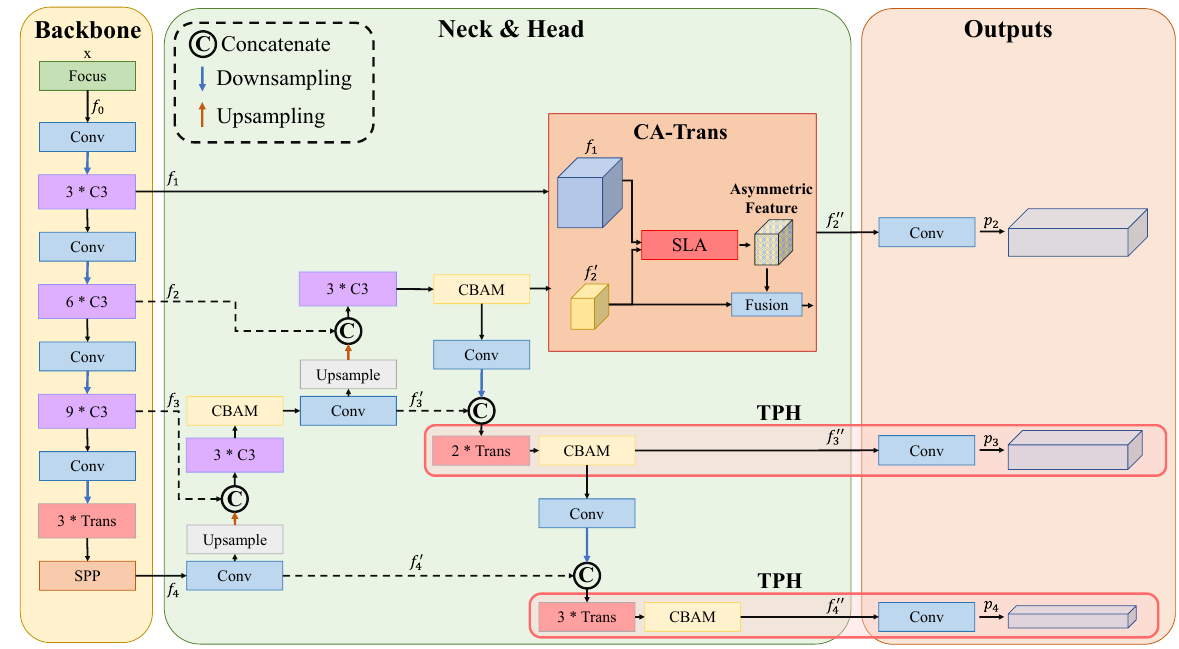
Figure 6. The overall architecture of TPH-YOLOv5++. Different from the TPH-YOLOv5, TPH- YOLOv5++ removes the additional head and introduces the CA-Trans to enrich the features of small paths. The CA-Trans takes f 1 and f (cid:48) as inputs and outputs f (cid:48)(cid:48) . After a Conv. layer, a new p 2 is 2 2 predicted to absorb the best of the original p 1 and p 2